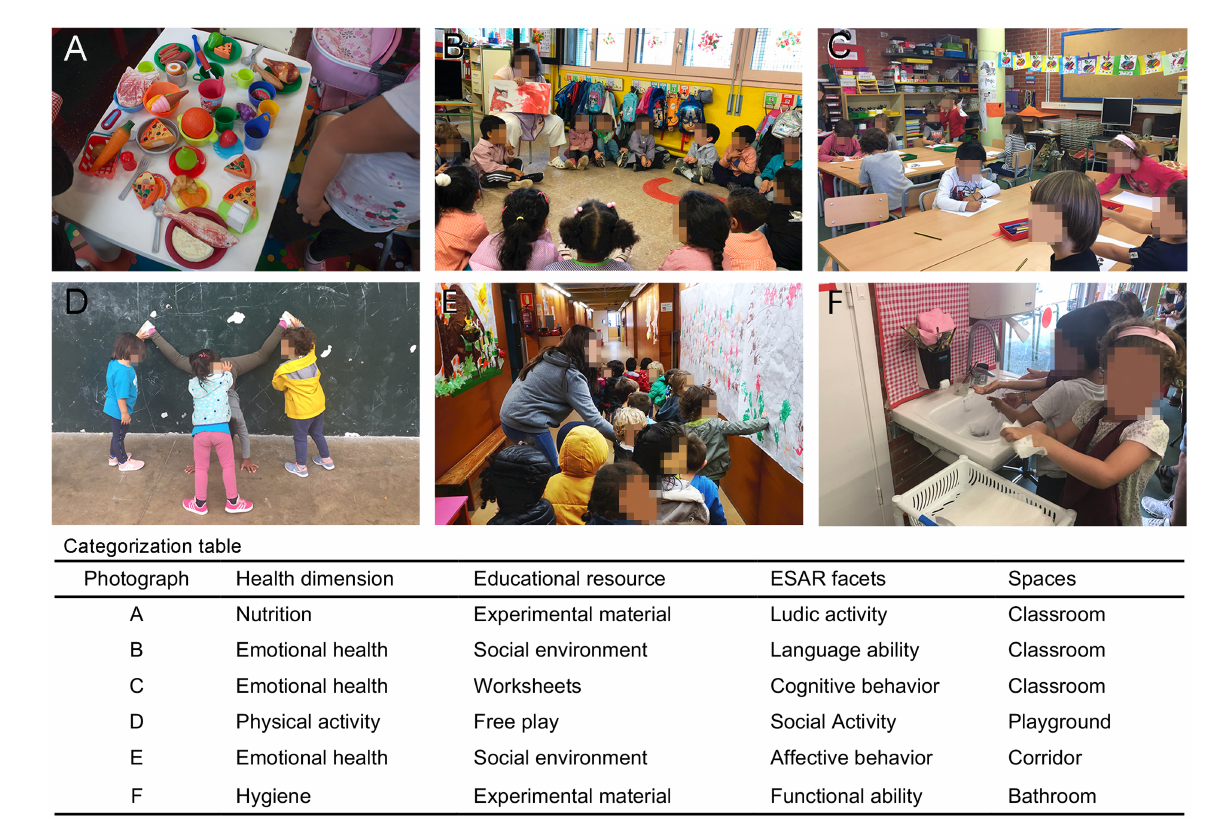
FIGURE 1 Classification of photographs into the different categories of four variables of the study. (A–F) Illustrative photographs taken in the study; Written informed consent to take photographs at the school was obtained from the individuals participating in this study and /or their representatives; people’s faces have been blurred to ensure privacy. The categorization table shows the classification of these six photographs into the categories of the health dimension, educational resource, ESAR Facets, and Spaces variables. See text for